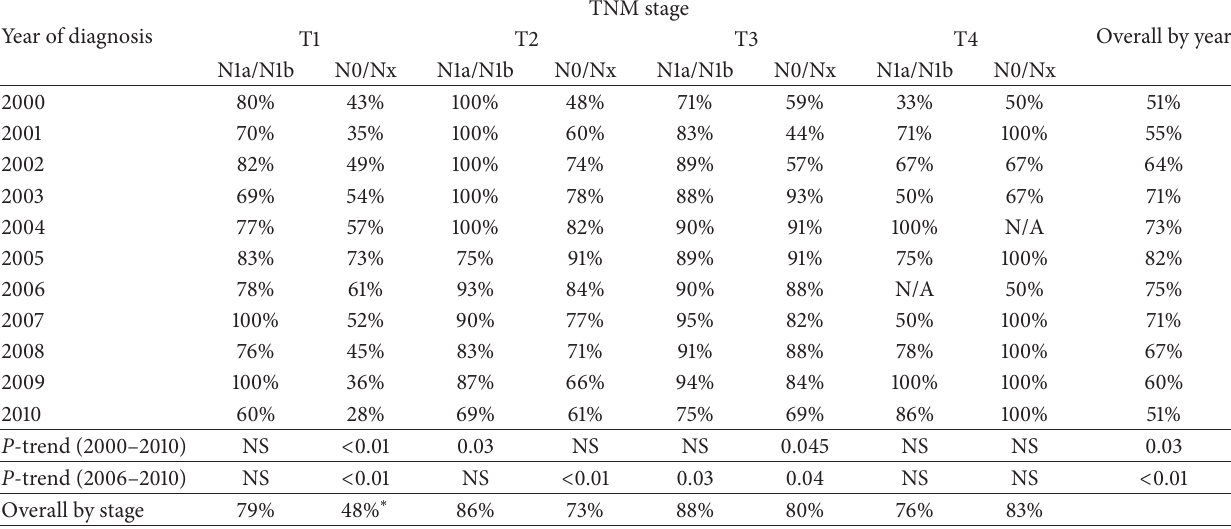
Table 4: Percentage of patients receiving RAI over time (all centers combined).